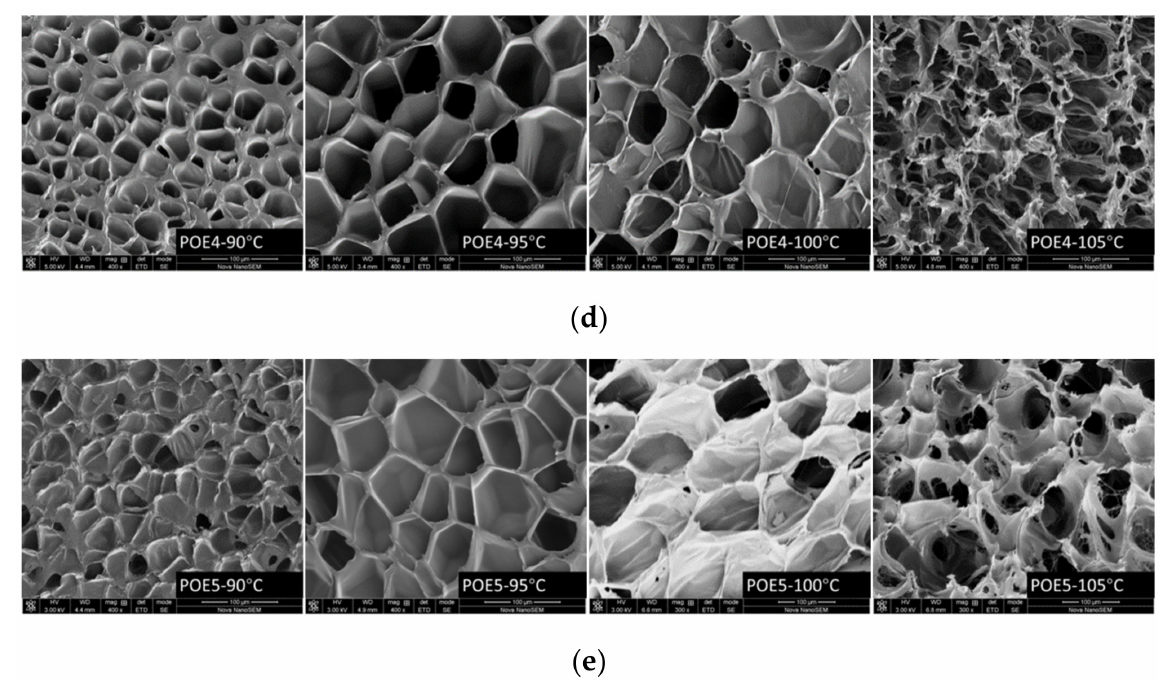
Figure 9. SEM micrographs of POE foams prepared at different temperatures. The SEM was captured after the sample had been annealed in air at room temperature for 21 days. ( a ) POE1; ( b ) POE2; ( c ) POE3; ( d ) POE4; ( e ) POE5.